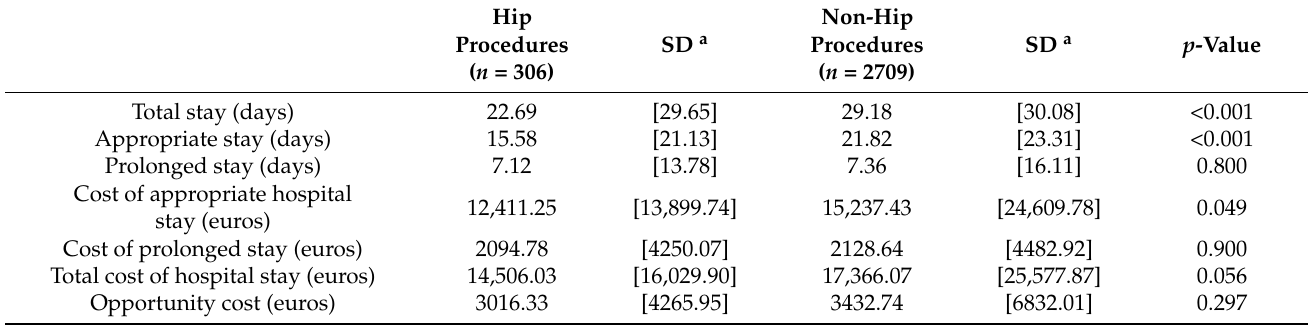
Table 2. Patients with hip procedures compared with patients without hip procedures (length of stay and costs). Cantabria (northern Spain), 2007–2015.